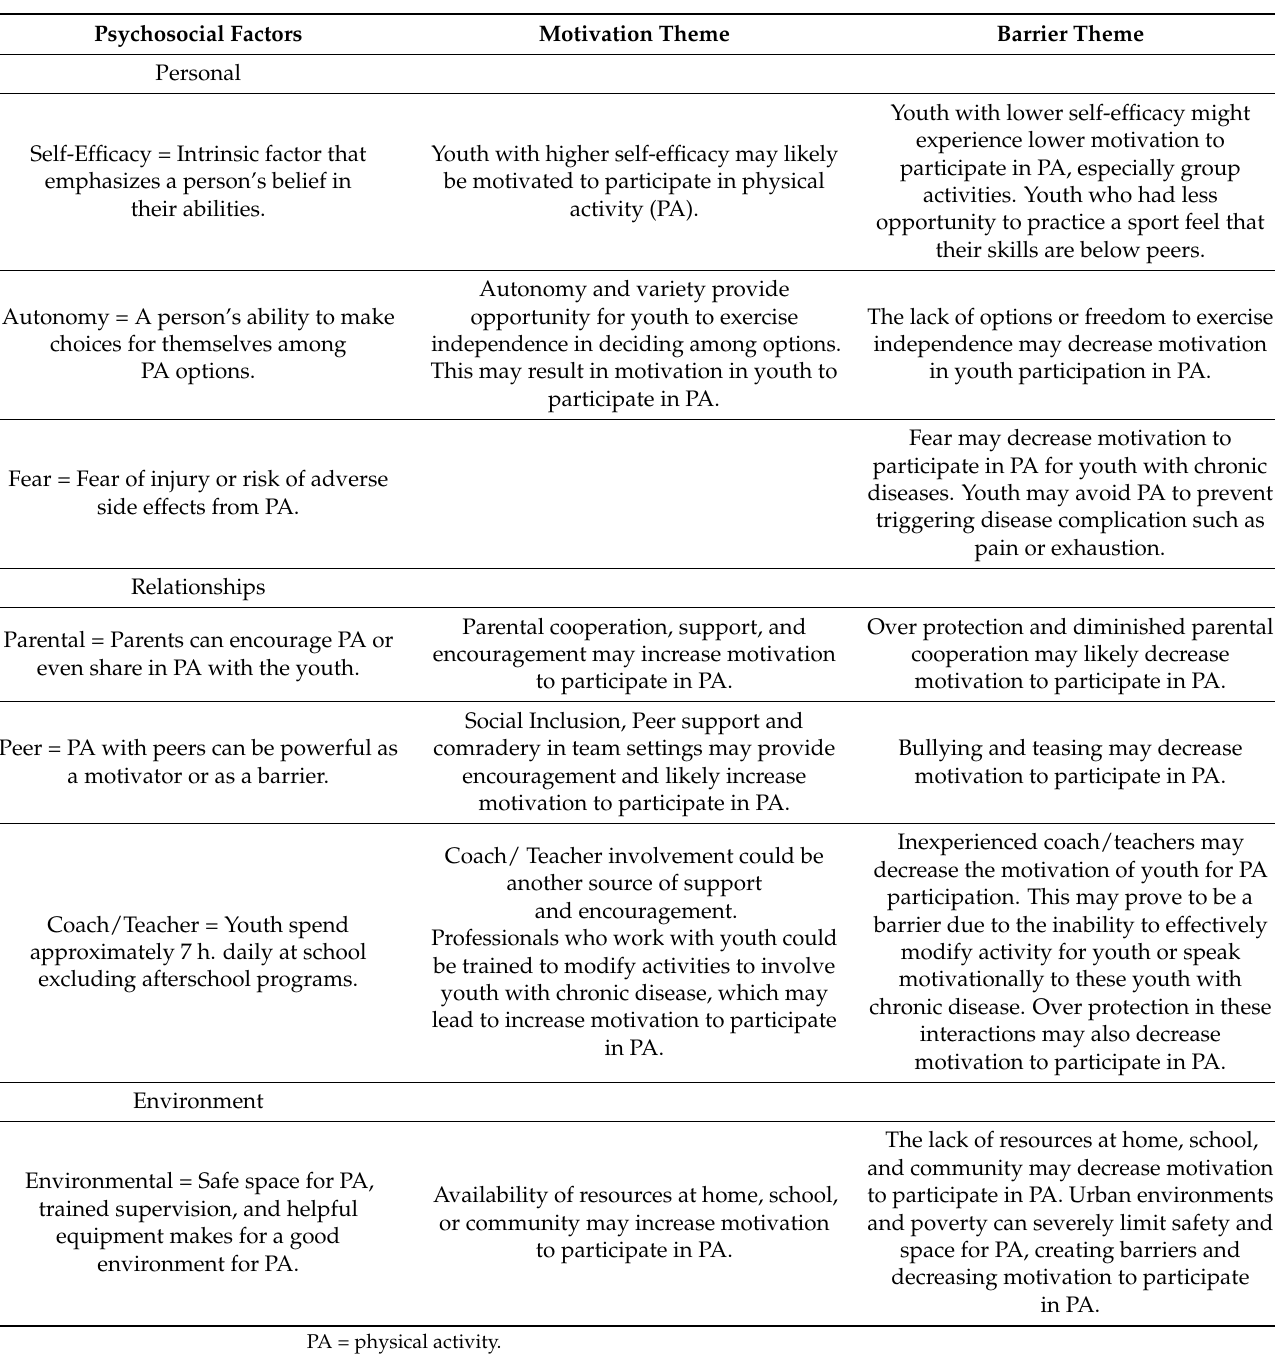
Table 1. Thematic analysis results using social ecological